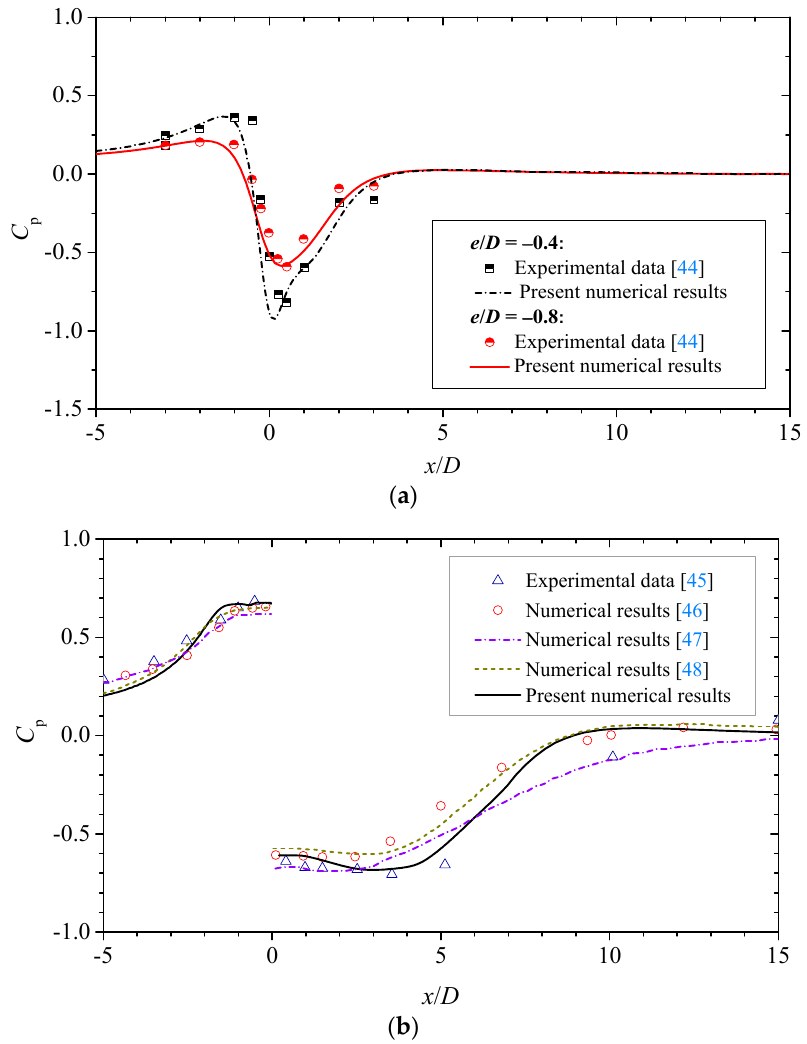
Figure 4. Distribution of the pressure coefficient ( C p ) at the mudline around the pipe (the pipe is located at x/D = 0): ( a ) e/D = − 0.4, − 0.8, Re = 1.5 × 10 4 ; ( b ) e/D = 0, Re = 4.5 × 10 4 .